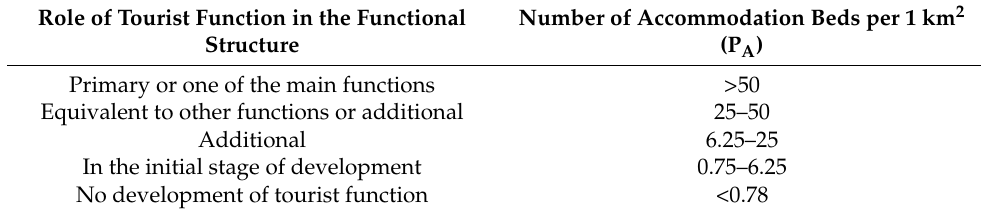
Table 2. The accommodation density index (based on Mika, 2004 [51], modified). Role of Tourist Function in the Functional Structure Primary or one of the main